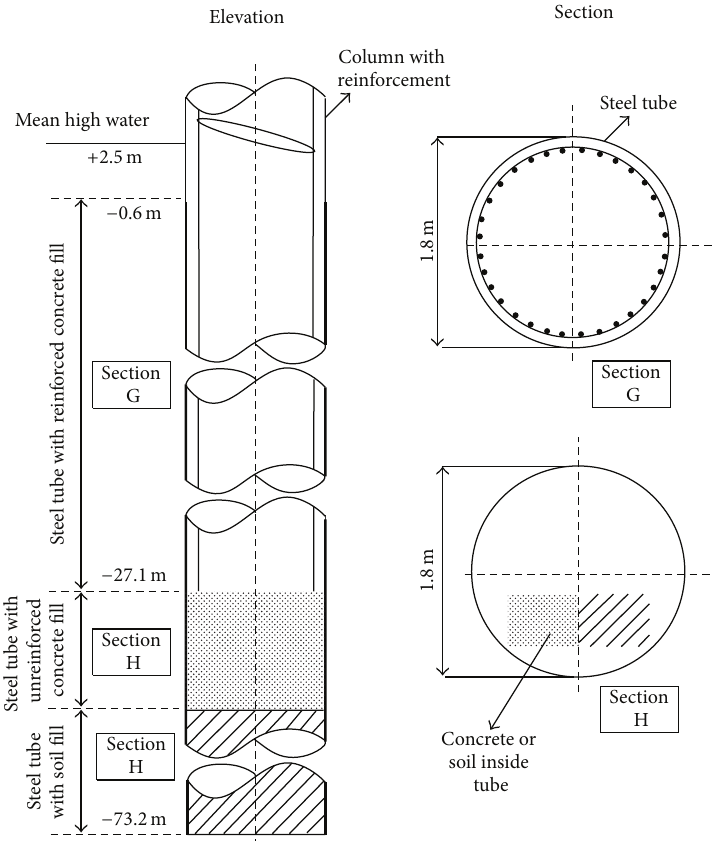
Figure 1: Pier No. 4 Caisson Ebey